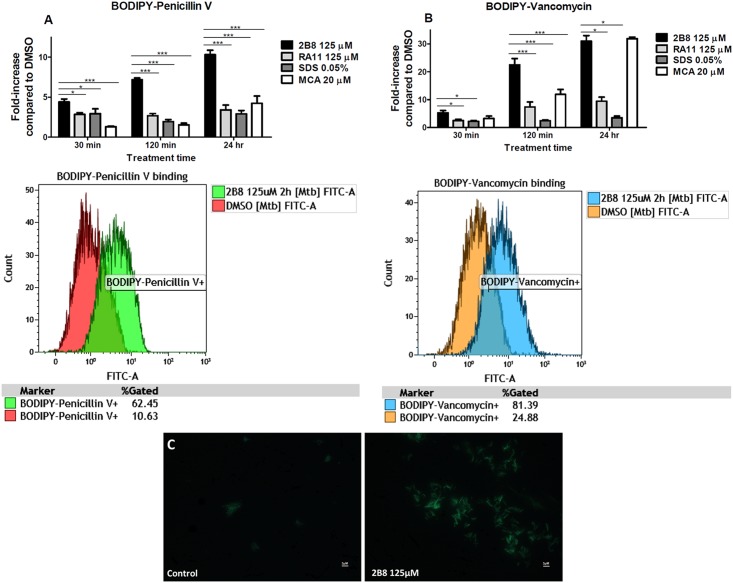
2-AI increased penicillin V and vancomycin binding to M. tuberculosis.A and B) Representative histogram overlays from flow cytometry analysis (right panels) of BOCILLIN® or BODIPY® FL vancomycin stained M. tuberculosis after treatment with 125 μM 2B8 or DMSO control. Fold-change staining (left panels) was determined by dividing percent of positively-stained treated bacteria by percent of positively-stained DMSO control bacteria. For BOCILLIN®, a time-dependent increase in staining was observed with 2B8, but not with RA11, SDS or MCA treatment. 2B8 treatment also increased staining with BODIPY® FL vancomycin to a significantly higher extent in a time-dependent manner compared to RA11 or SDS treatment. MCA treatment resulted in a time-dependent increase of BODIPY® FL vancomycin staining as expected. C) Fluorescent images (×1000) of M. tuberculosis stained with BODIPY® FL vancomycin after treatment or not with 125 μM 2B8 for 120 min. Treatment with 2B8 (right panel) resulted in increased number of bacteria with higher fluorescence intensity than DMSO control. *p<0.05, **p<0.01, ***p<0.05 by ANOVA. Experiments were repeated three separate times in triplicates and results were pooled together for statistical analysis. For clarity, significance is only shown for control and 2-AI compound treatment.